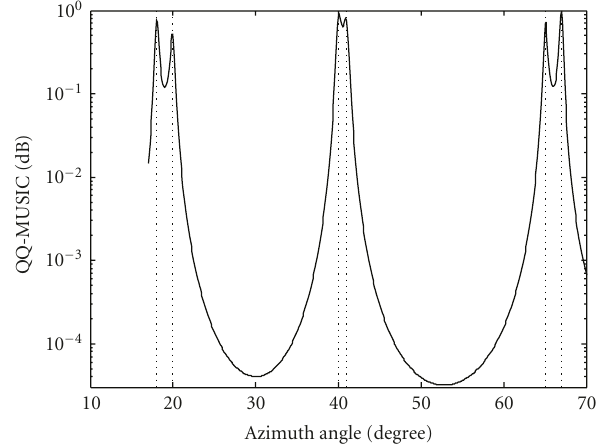
Figure 10: QQ-MUSIC spectrum in the presence of several close signals; SNR = 30 dB, the number of snapshots is 100.